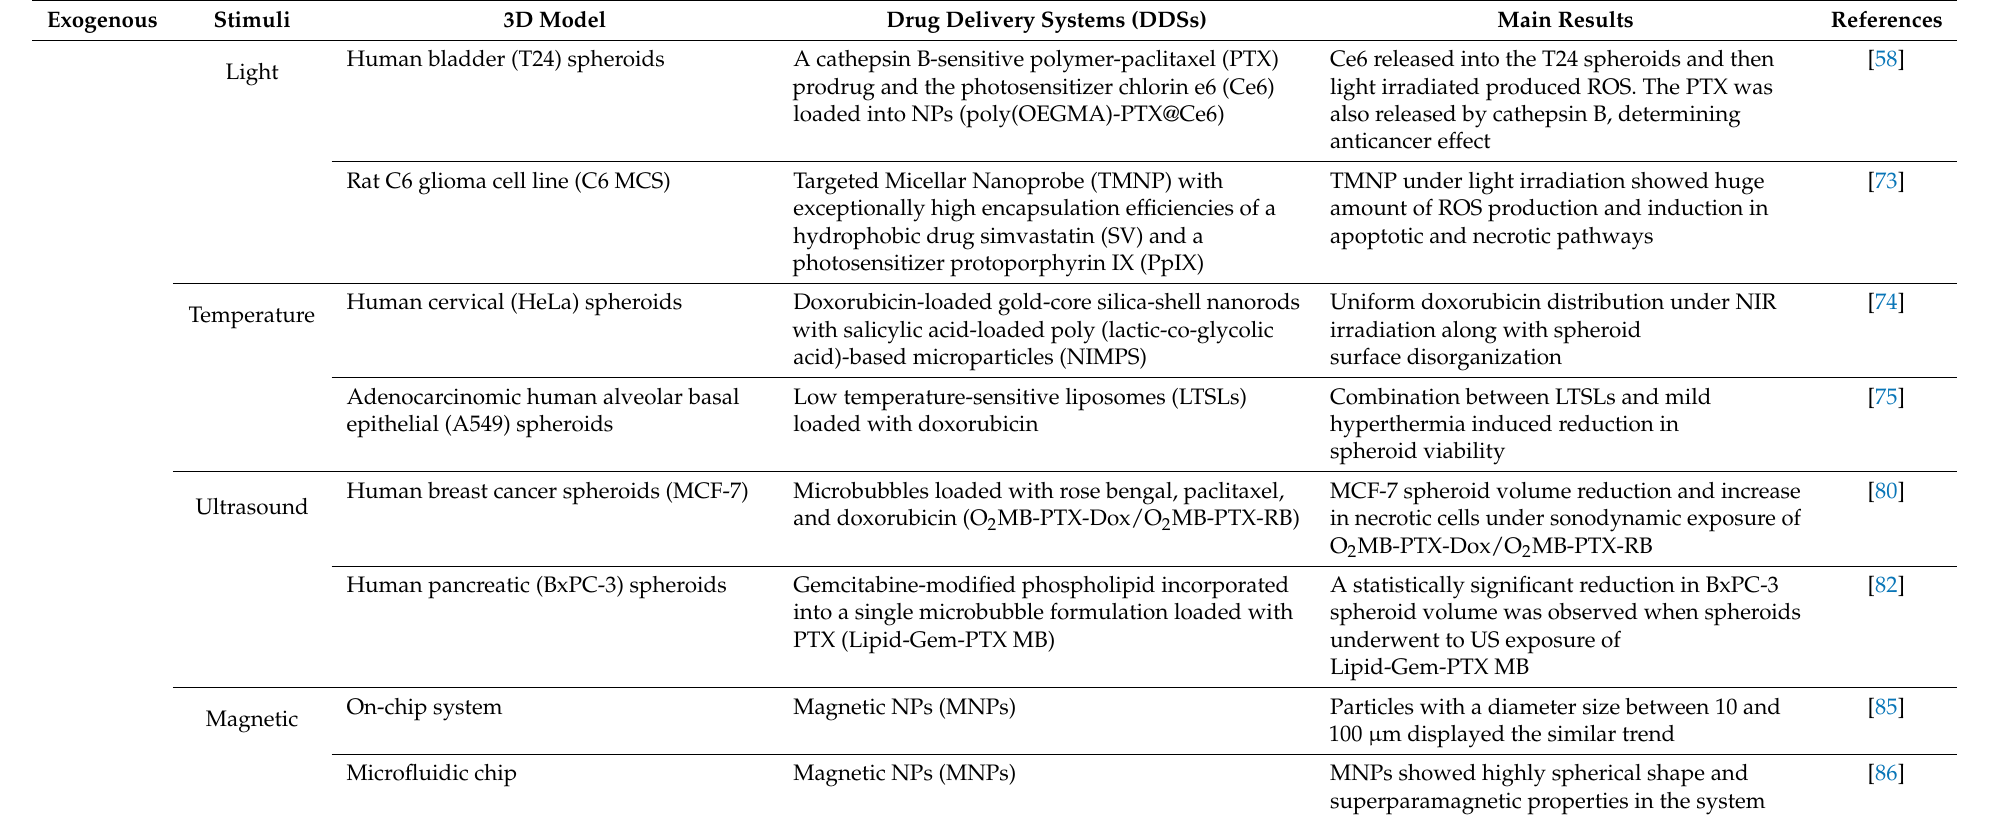
Table 3. Exogenous stimuli-responsive DDSs in 3D cancer